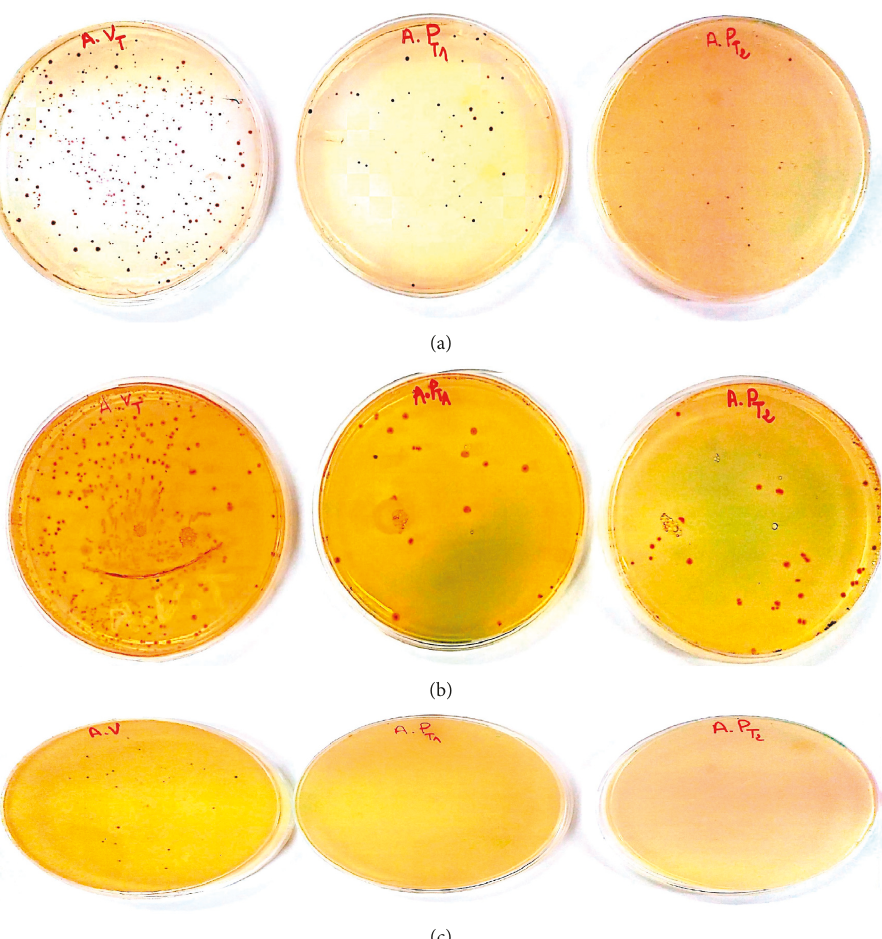
Figure 7: The results of bacteriological enumeration of crude effluent, RS and C S filtrate. (a) Fecal coliforms, (b) fecal Streptococci , and (c) Staphylococcus aureus